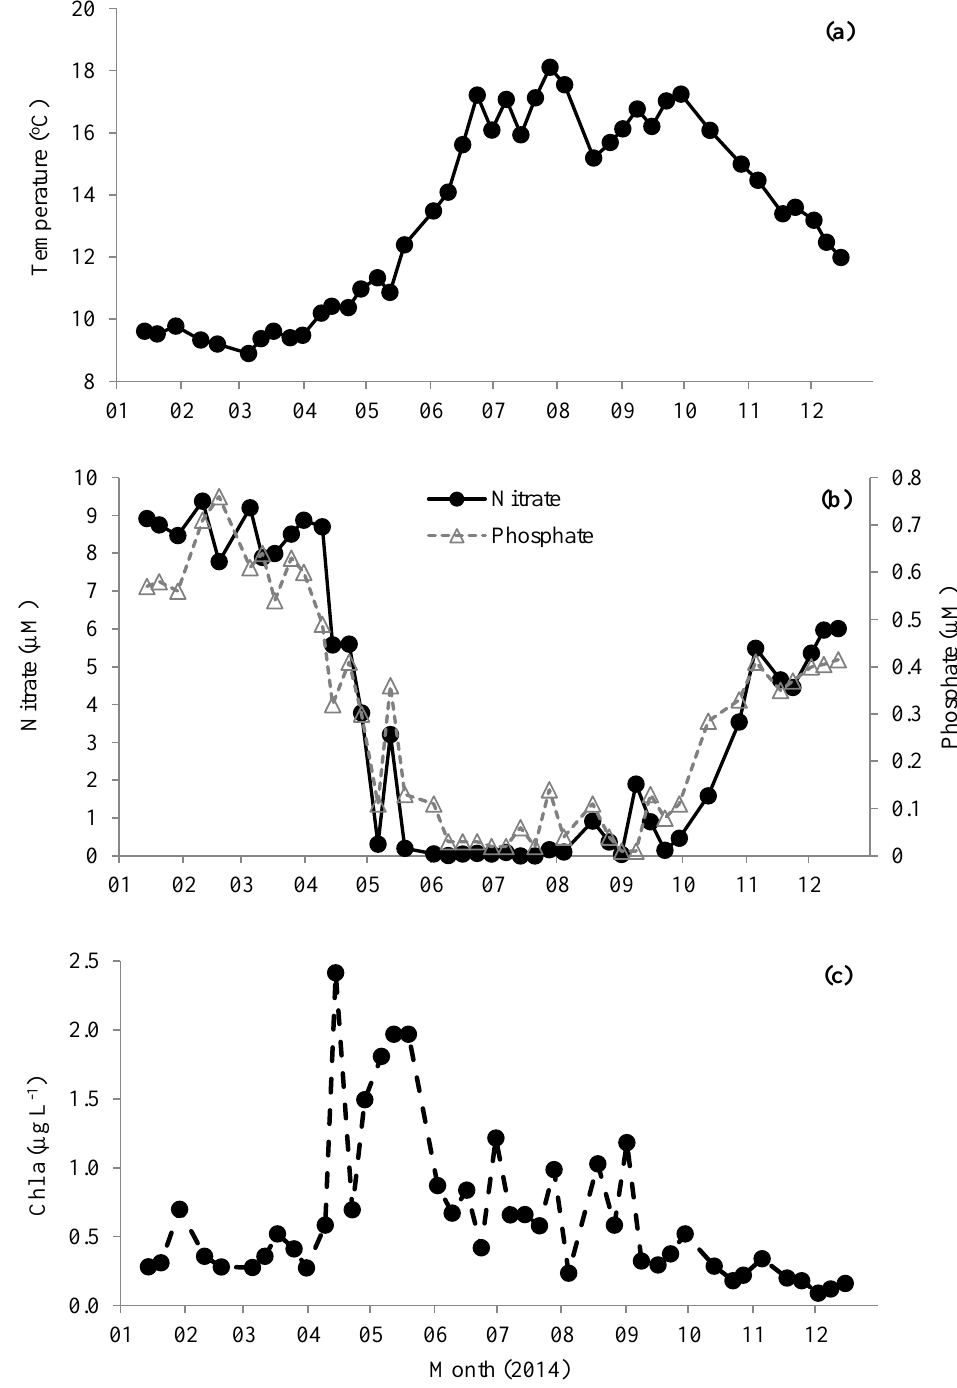
Figure 1. Change in ( a ) sea surface temperature, ( b ) inorganic nutrient concentrations of nitrate and phosphate, and ( c ) chlorophyll a in surface waters of station L4 in the western English Channel during 2014.